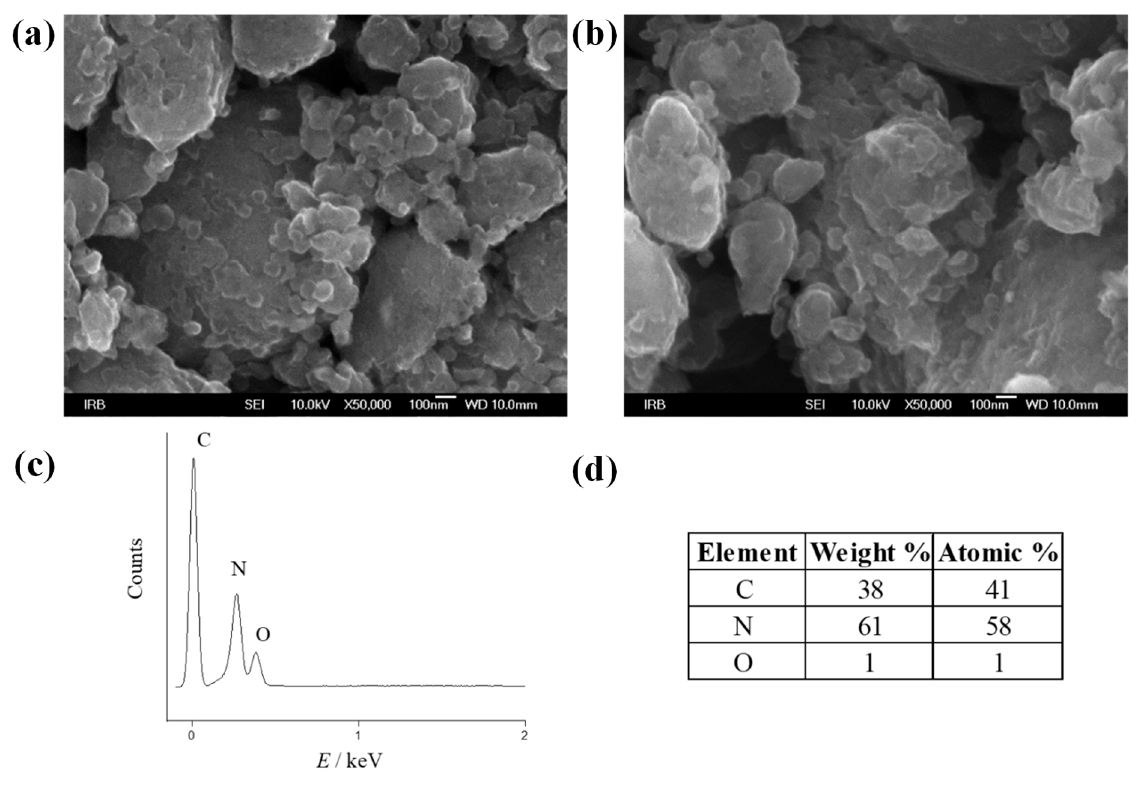
Figure 2. ( a , b ) Scanning electron microscopy (SEM) images and ( c , d ) energy-dispersive X-ray (EDX) spectra of the raw